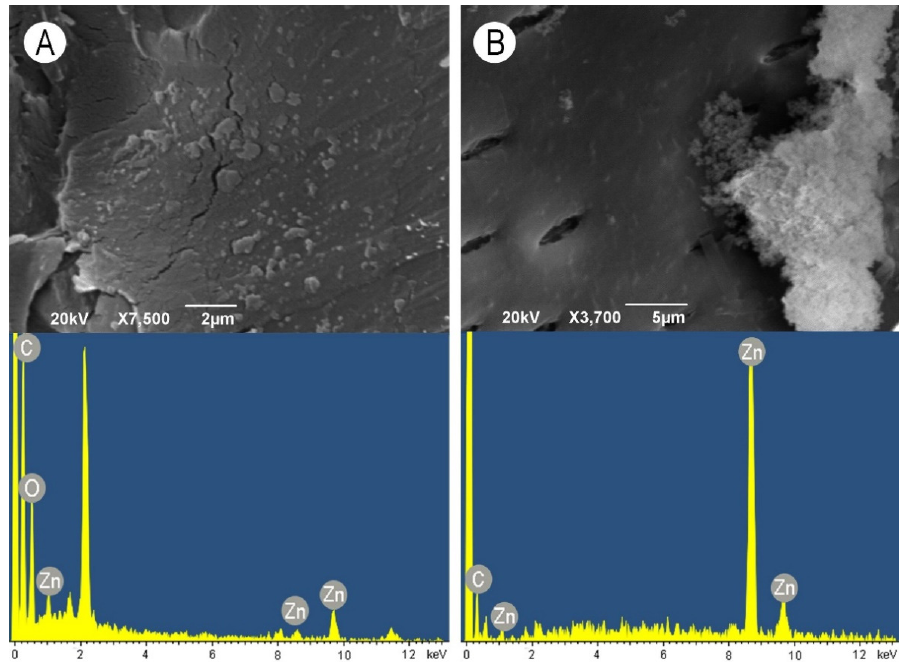
Figure 9. Scanning electron microscopy images of earlywood vessel wall surfaces (upper images) accompanied with the representative EDX spectra showing the elemental composition (bottom images). ( A ) ZnO nanoparticles, radial section, scale bar = 2 µ m. ( B ) Aqueous solution of water glass in combination with ZnO nanoparticles, radial section, scale bar = 5 μ m.